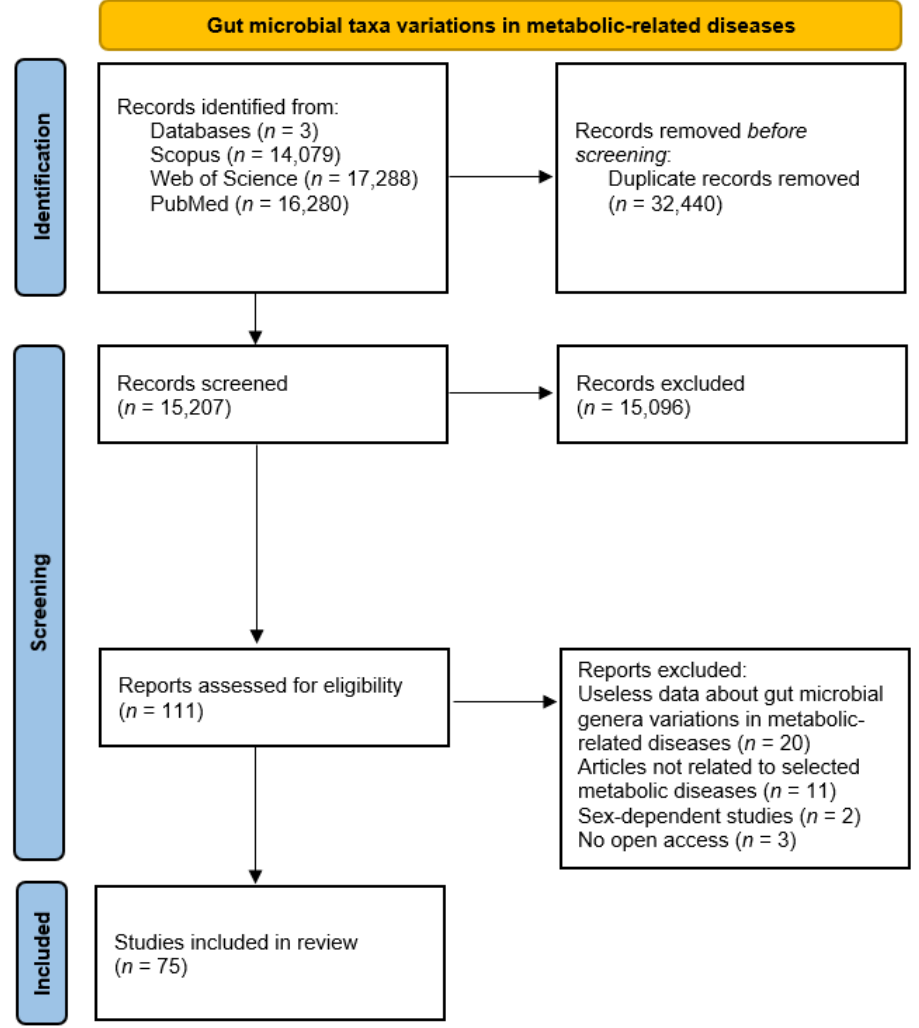
Figure 1. PRISMA diagram for gut microbial taxa changes in metabolic diseases.